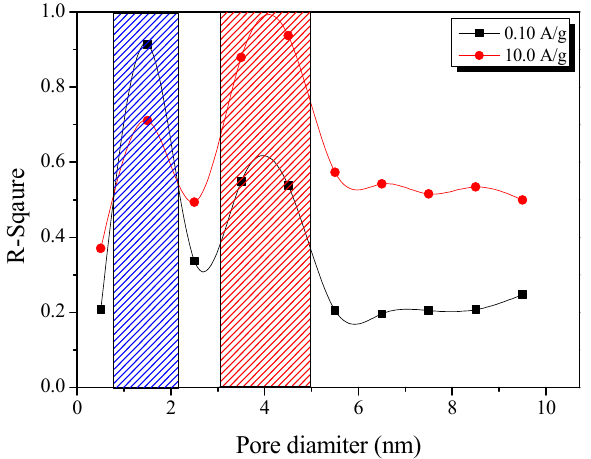
Figure 10. Correlation between the specific capacitance of the PB-AC samples and pore volume. The x -axis shows the average PSD plotted as pore volume according to pore diameter in 1 nm units using the average value of each PSD.